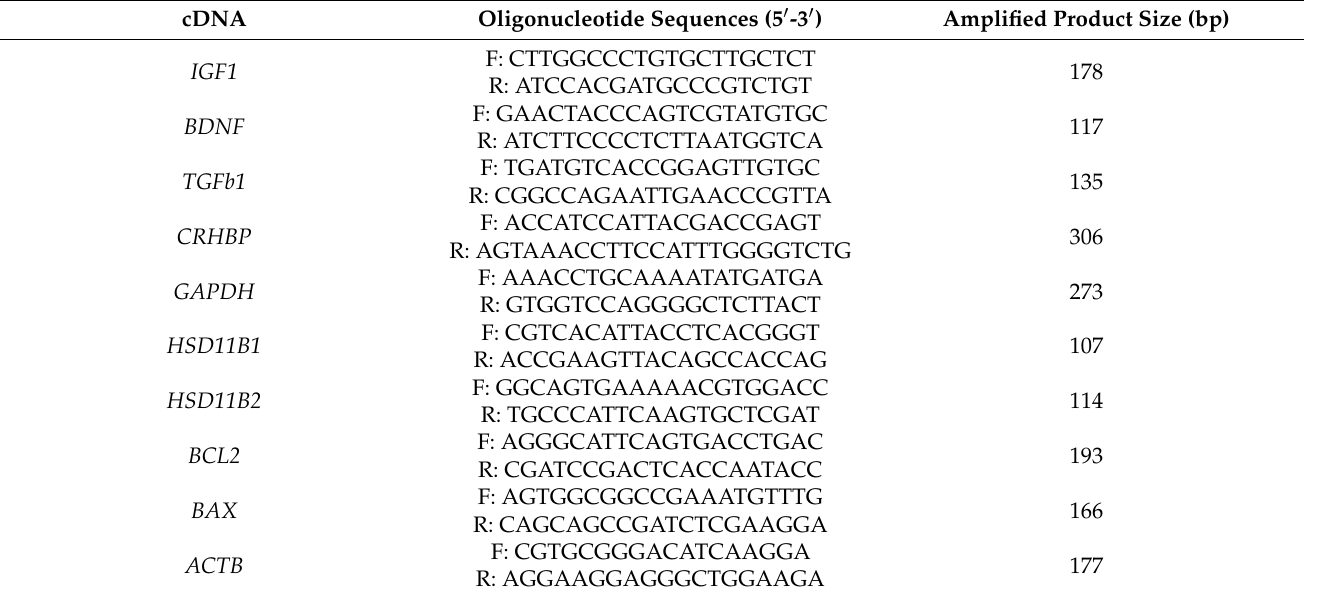
Table 1. Oligonucleotide primer sequences used for real-time PCR in this